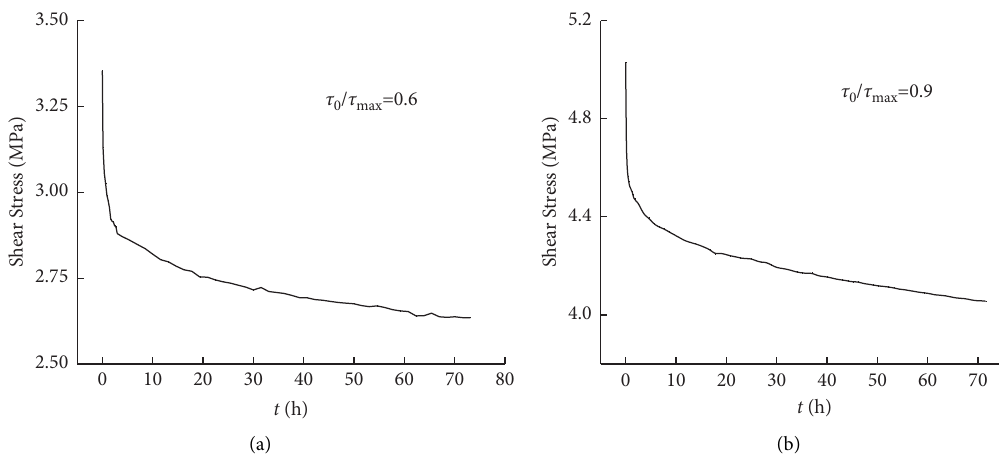
Figure 8: Relaxation curves of 45 ° discontinuities under single-stage loading: (a) τ